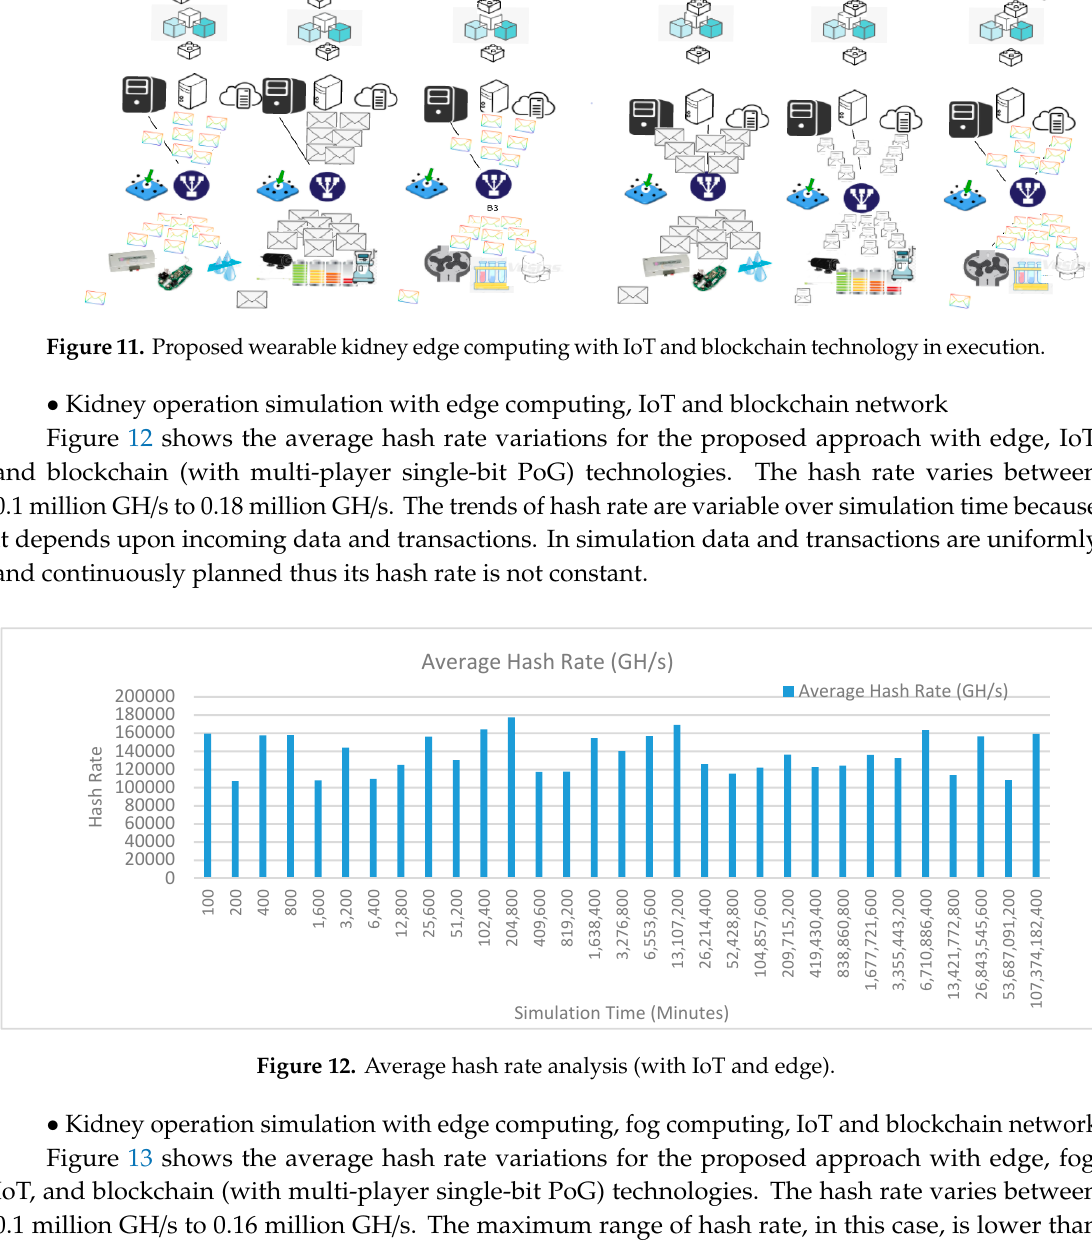
Figure 11. Proposed wearable kidney edge computing with IoT and blockchain technology in execution.